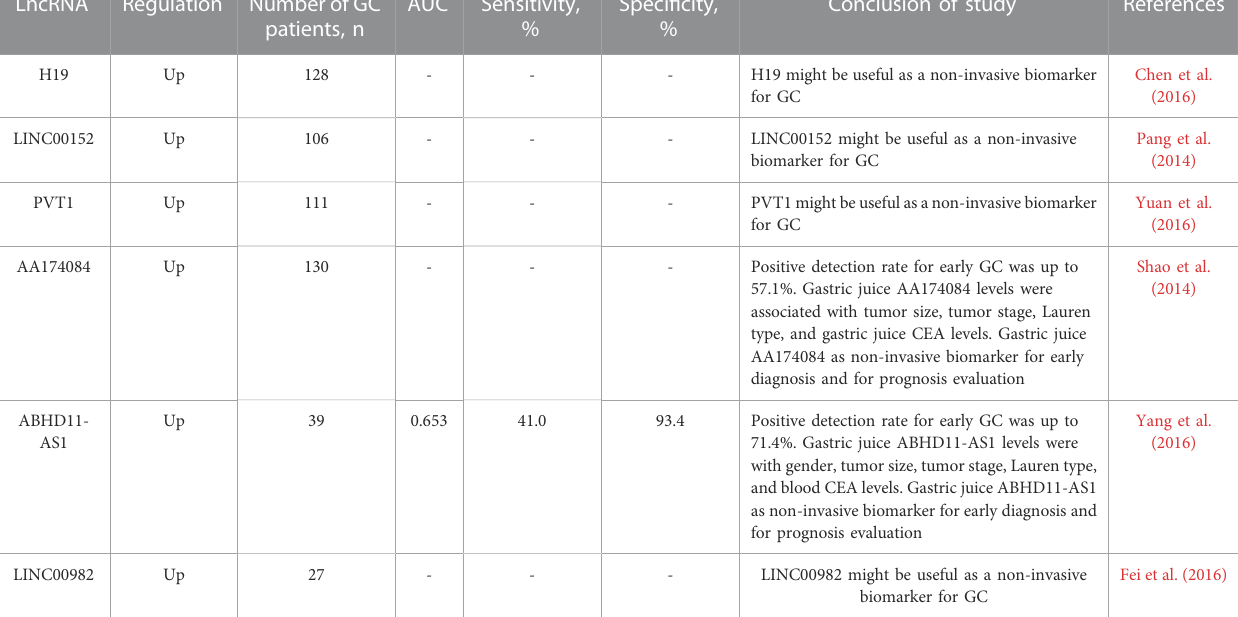
TABLE3Summarizedseverallongnon-coding RNAs(lncRNAs)presentingmodi fi edcirculatingexpressioningastricjuice ofgastriccancer(GC)patientscompared to healthy controls or benign gastric diseases.